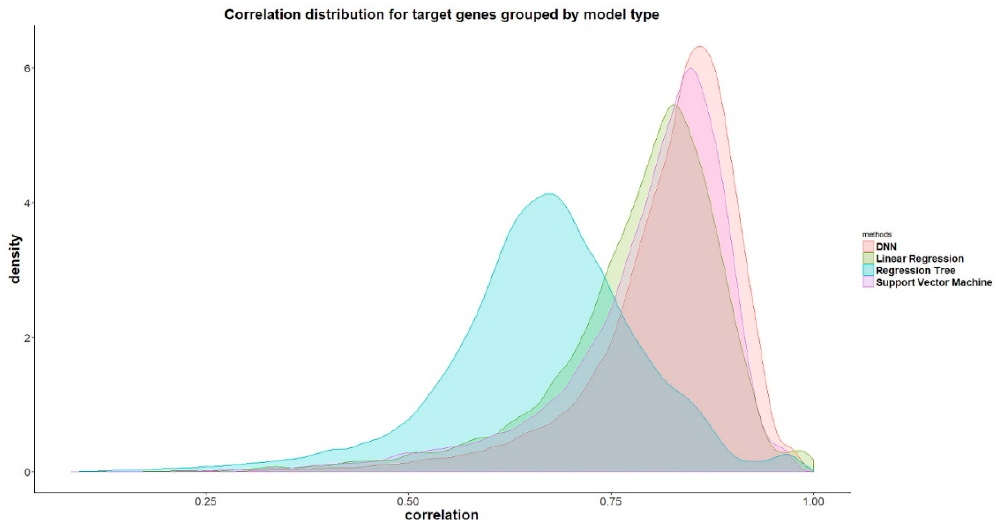
Figure 8. The density plots of the PCC of all the target genes by LR, RT, SVM, and D-GPM for MBV- te.